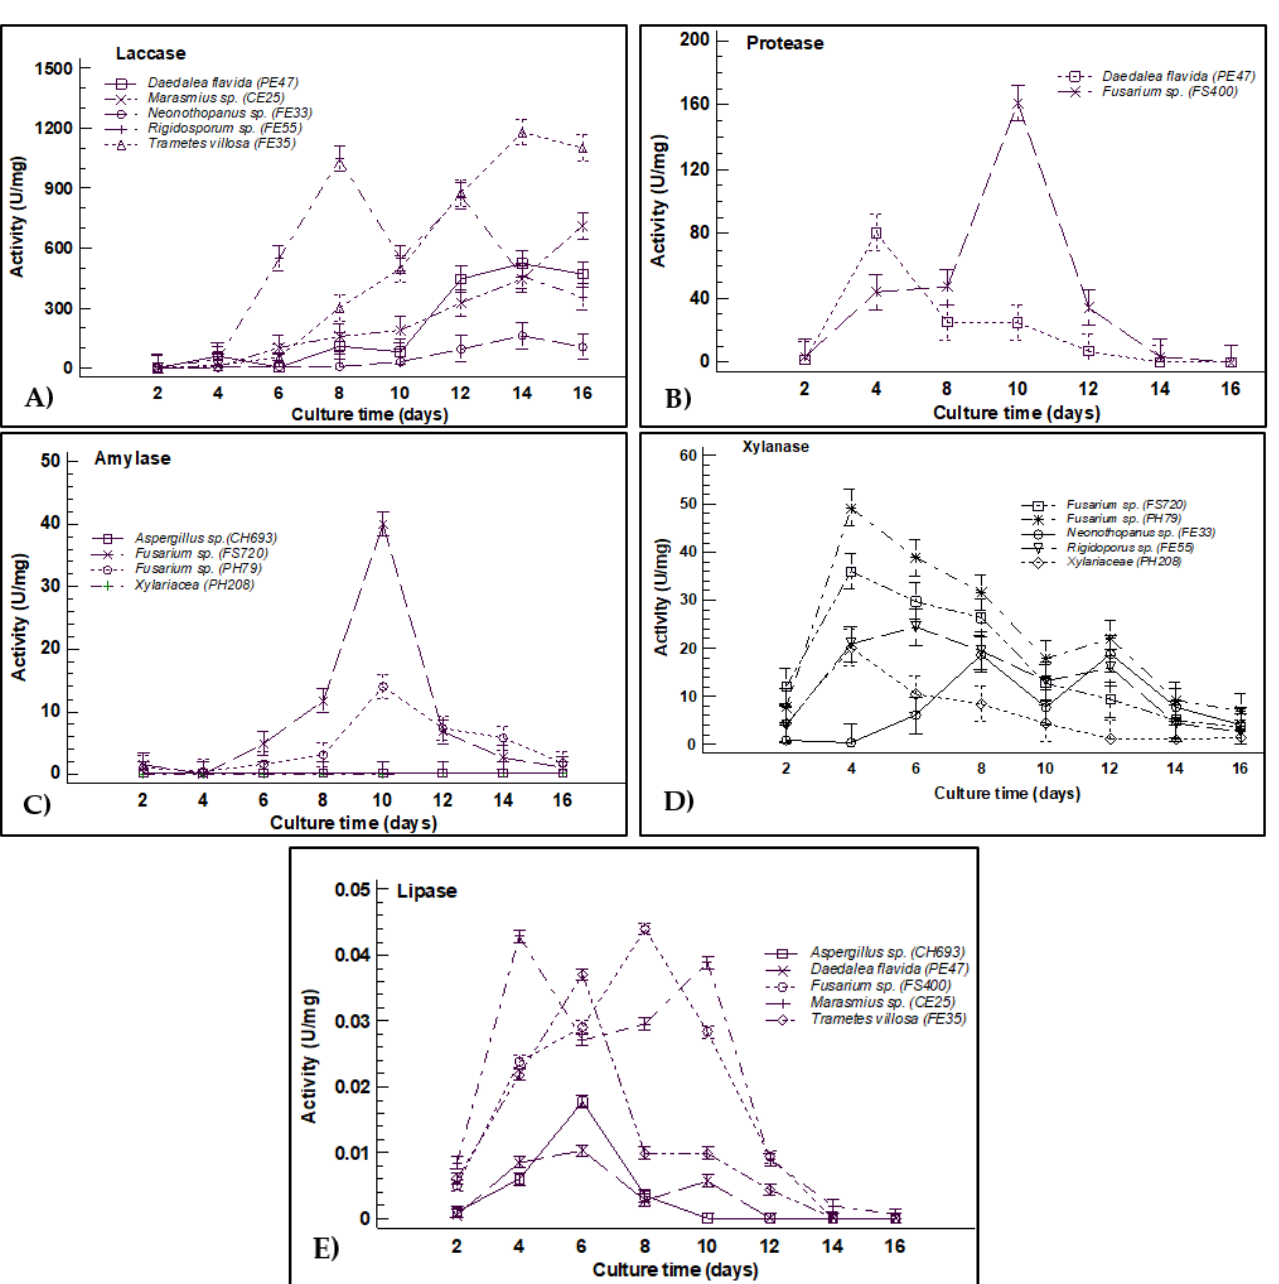
Figure 3. Enzymatic activity quantification of the ten selected fungi expressed in U/mg: ( A ) Laccase, ( B ) Protease, ( C ) Amylase, ( D ) Xylanase, and ( E ) Lipase. The hydrolysis of casein during the quantification of proteases showed a maximum expression point after 10 days of culture of Fusarium sp. FS400 with 160.61 U/mg (88.33 U/mL) followed by Daedalea flavida PE47 with 80.67 U/mg (47.24 U/mL) after four days of culture (Figure 3B). For amylases, only two strains of Fusarium spp. (PH79 and FS720) from leaf litter and soil, respectively, showed amylase activity after 10 days of culture with 14 U/mg (0.998 U/mL) and 40 U/mg (2.27 U/mL). Regarding Aspergillus sp. CH693 and Xylariaceae PH208, under the culture conditions, these strains did not show amylase en- zyme activity (Figure 3C). Xylanase activity was detected in fungi isolated of the three sources, showing the maximum activities at four and six days of culture using Fusarium sp. PH79 with 49.23